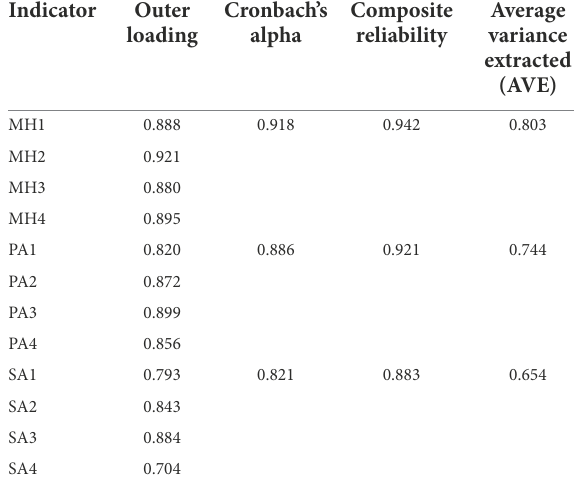
TABLE 3 Factor loading, reliability, and validity.